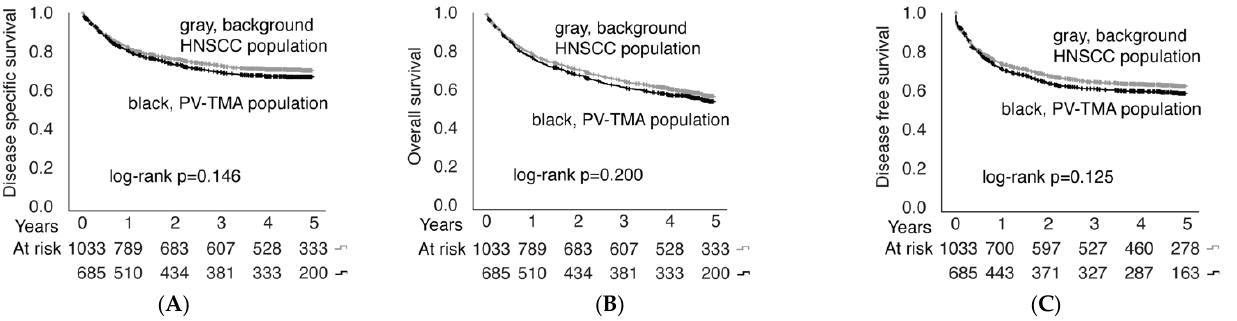
Figure 5. Overall survival ( A ), disease-specific survival ( B ) and disease-free survival ( C ) comparison between PV-TMA and background HNSCC populations. Table 3. Univariate (left panel) and multivariate (right panel) analyses of TMA inclusion bias, including odds ratios (ORs), 95% confidence intervals (CIs), and p values. The results from binomial logistic modeling. Alcohol use was defined as 10 doses or more per week at the time of diagnosis.